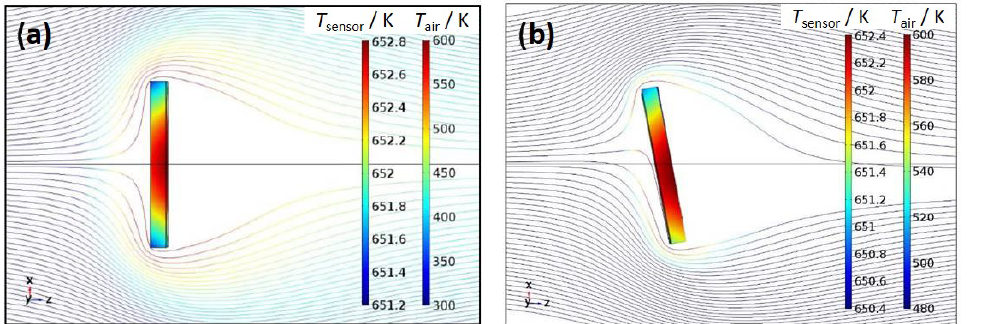
Figure 2. Simulated flow lines around a sensor element (cross section in top view) for a 90 ◦ orientation (a) and a slightly rotated case (b) . Coloring indicates the temperature distribution (simulation parameters are as follows: gas flow 1Lmin − 1 , gas temperature 20 ◦ C, sensor heating 1.27W).